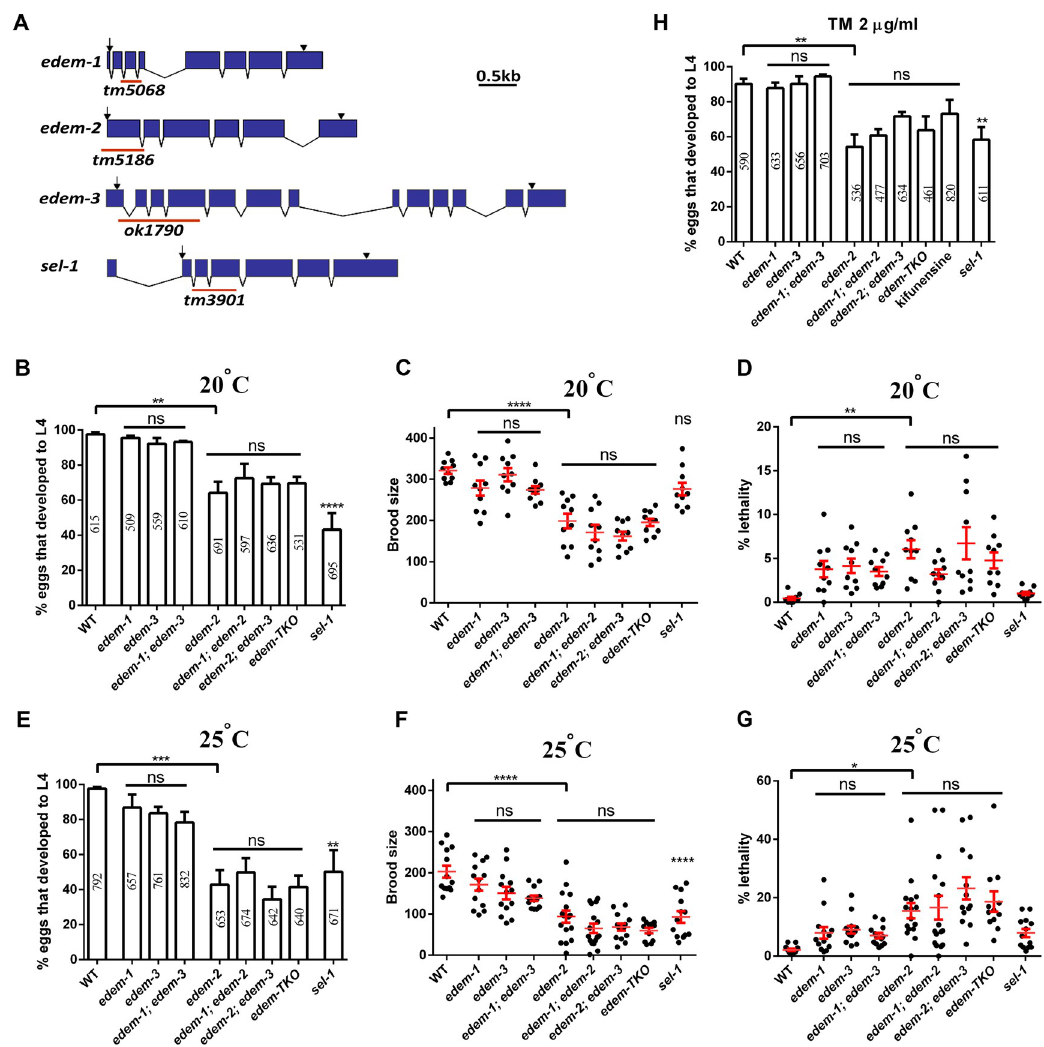
Fig 3. Phenotypes of edem mutants under physiological conditions. (A) Genomic organization of edem-1 , edem-2 and edem-3 genes. Exons are indicated by blue boxes and introns by lines; the ATG initiation (arrow) and termination codons (arrowheads) are indicated. The lines underneath indicate the position of deletion in the corresponding allele. (B) Growth rate of the indicated strains at 20˚C. Eggs were laid on the plates and the percentage of eggs that reached L4 stage 52h later was scored. Each strain was scored on three replicate plates in four independent experiments. (C) Brood size of the indicated strains at 20˚C. Each point represents the total brood of one hermaphrodite. (D) Percentage lethality of the indicated strains grown at 20˚C. Each point represents % lethality of progenies derived from one hermaphrodite. Lethality encompasses both embryonic and larval arrest. (E) Growth rate of the indicated strains at 25˚C. Eggs were laid on the plates and the percentage of eggs that reached L4 stage 48h later was scored. Each strain was scored on three replicate plates in five independent experiments. (F) Brood size of the indicated strains at 25˚C. Each point represents the total brood of one hermaphrodite. (G) Percentage lethality of the indicated strains grown at 25˚C. Each point represents % lethality of progenies derived from one hermaphrodite. Lethality encompasses both embryonic and larval arrest. (H) Growth rate under mild tunicamycin stress. Eggs were laid on the plates with 2 μ g/ml tunicamycin and the percentage of eggs that developed into L4 larvae after 3 days was scored. Each strain was scored on three replicate plates in four independent experiments. The red bars in C-D and F-G indicate the mean ± SEM. The values inside the columns in B, E and H represent the total number of eggs analyzed. � P < 0.05; �� P < 0.01; ��� P < 0.001; ���� P < 0.0001; ns, not